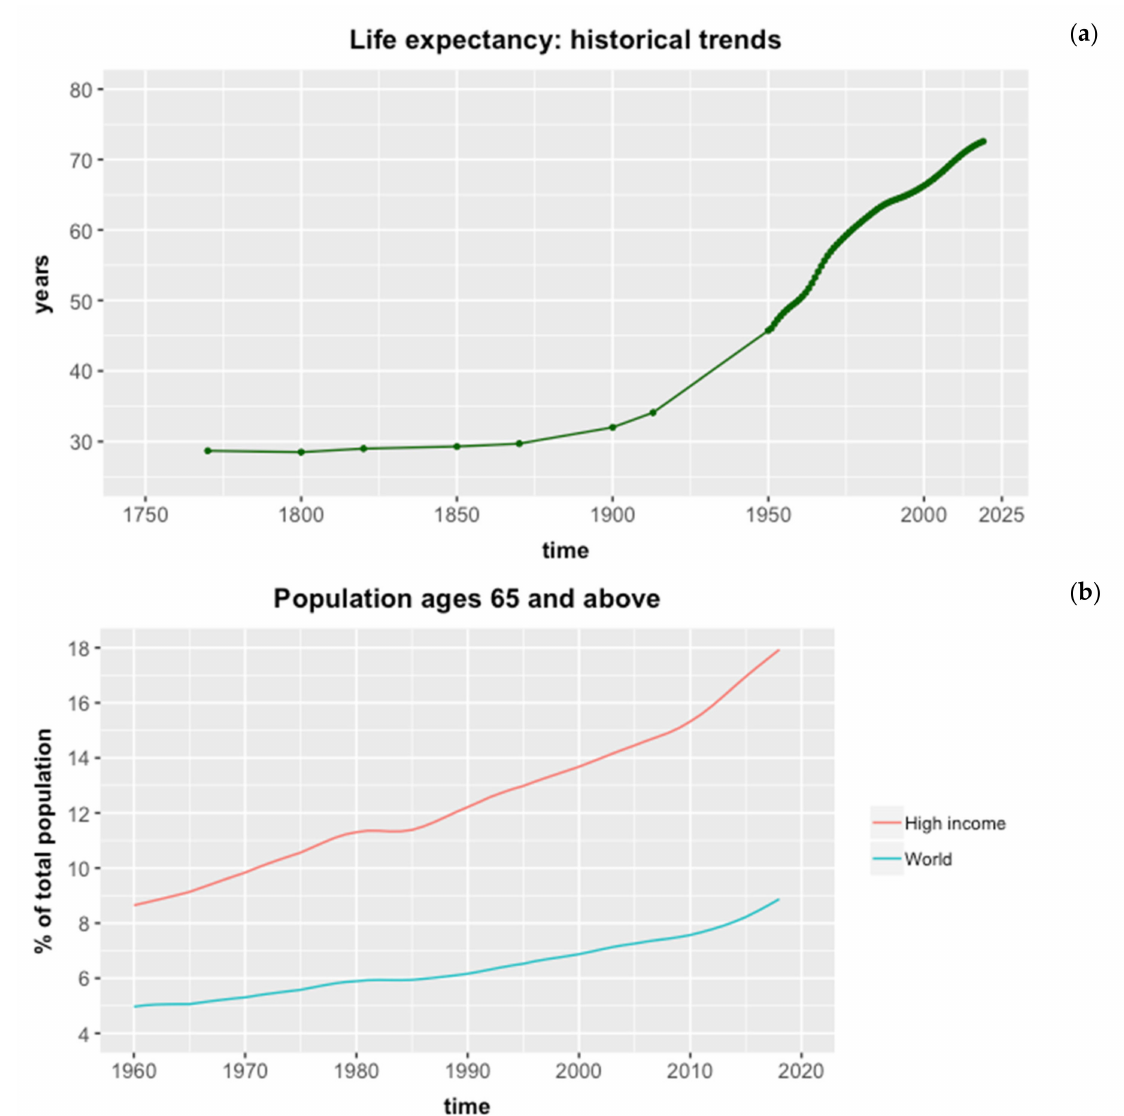
Figure 1. Life expectancy is constantly increasing. ( a ) Historical trends in life expectancy for the entire world [adapted from “Our World in Data”—Global Change Data Lab, University of Oxford (https://ourworldindata.org; accessed on 8 March 2021) and ( b ) proportion of population over 65 years old since 1960 adapted from “DataBank”—World Bank (https://databank.worldbank.org; accessed on 8 March